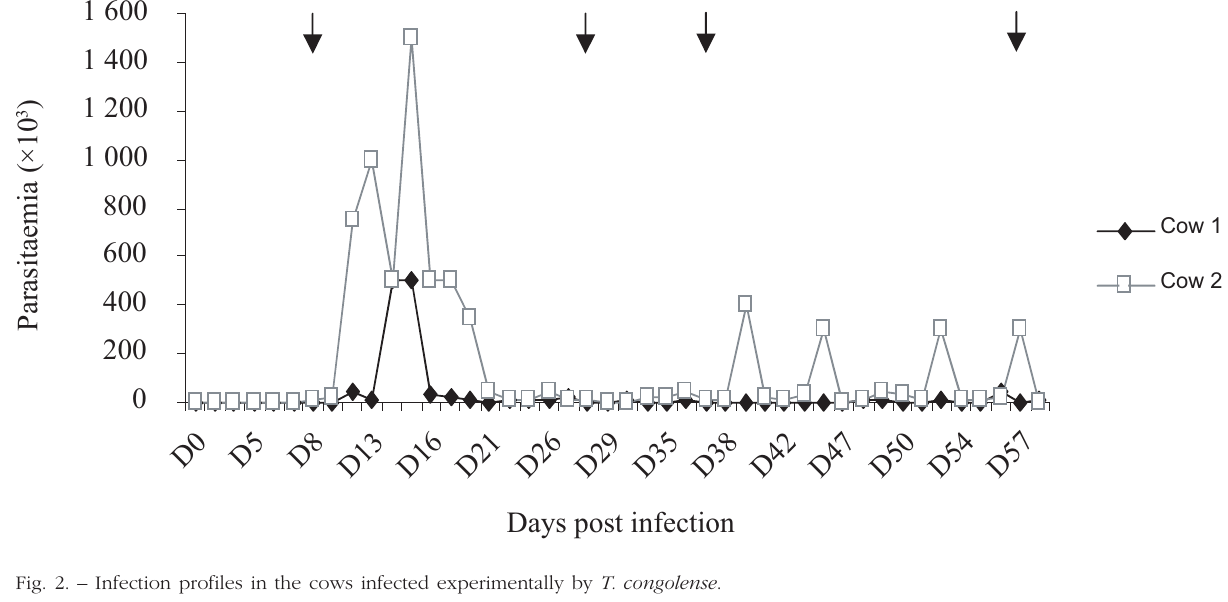
table.Fig. 2. – Infection profiles in the cows infected experimentally by T. congolense . Arrows indicate the time at which xenodiagnosis was performed with G. m. submorsitans on infected